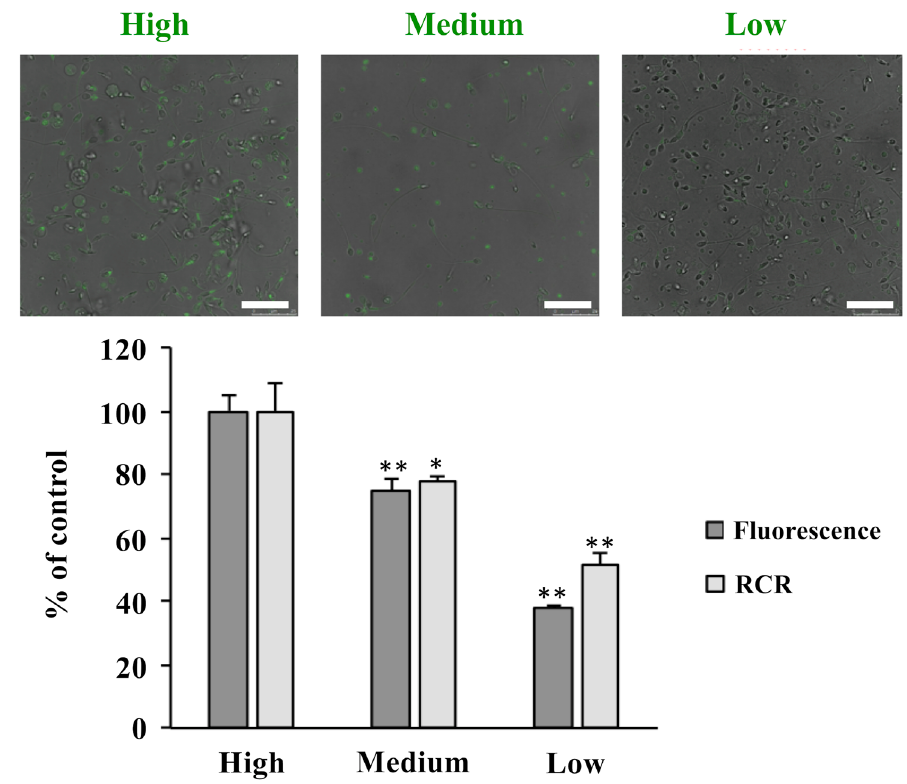
Figure 4. Correlation between sperm progressive motility and fluorescence intensity or respiratory control ratio (RCR) values.